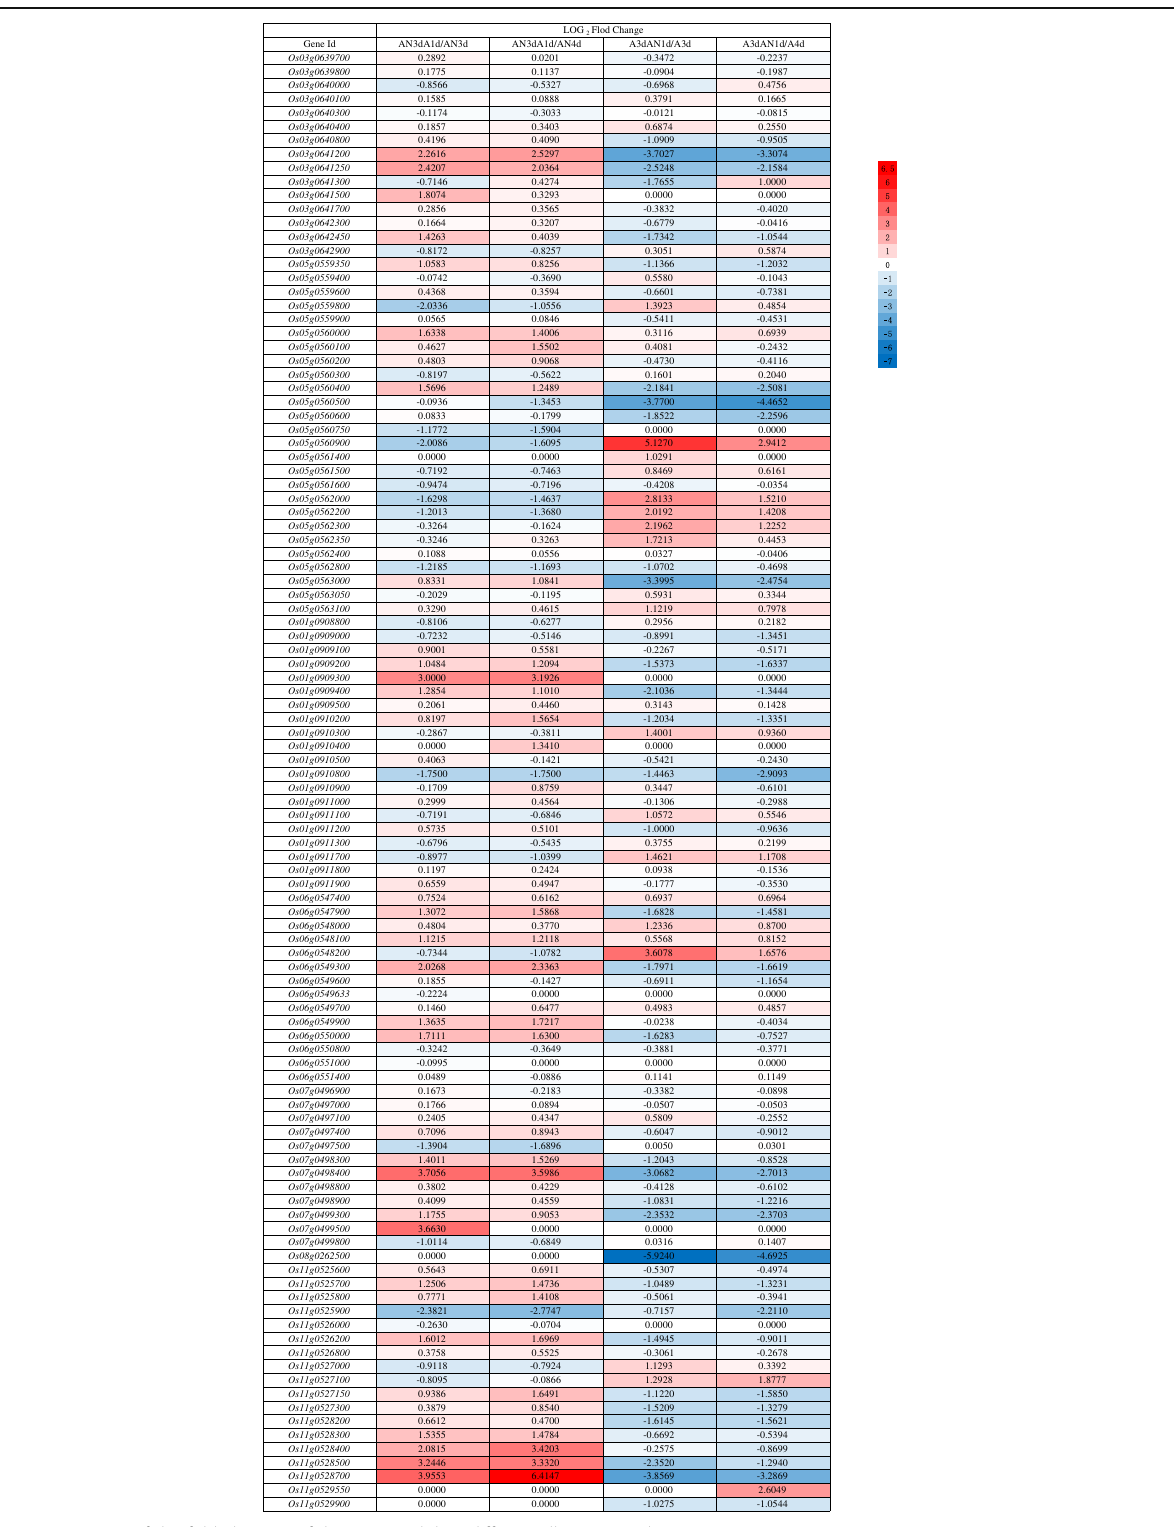
Fig. 6 Heat map of the fold changes of the 106 candidate differentially expressed genes